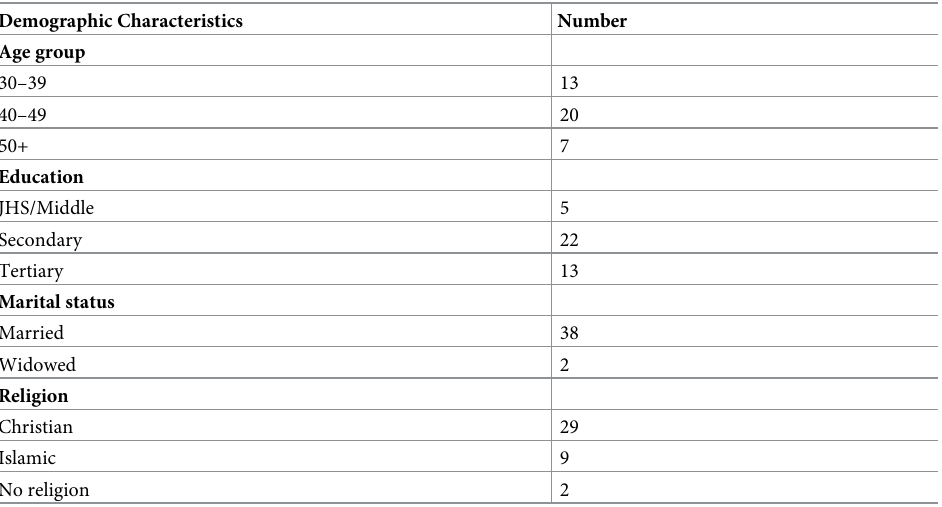
Table 1. Background characteristics of